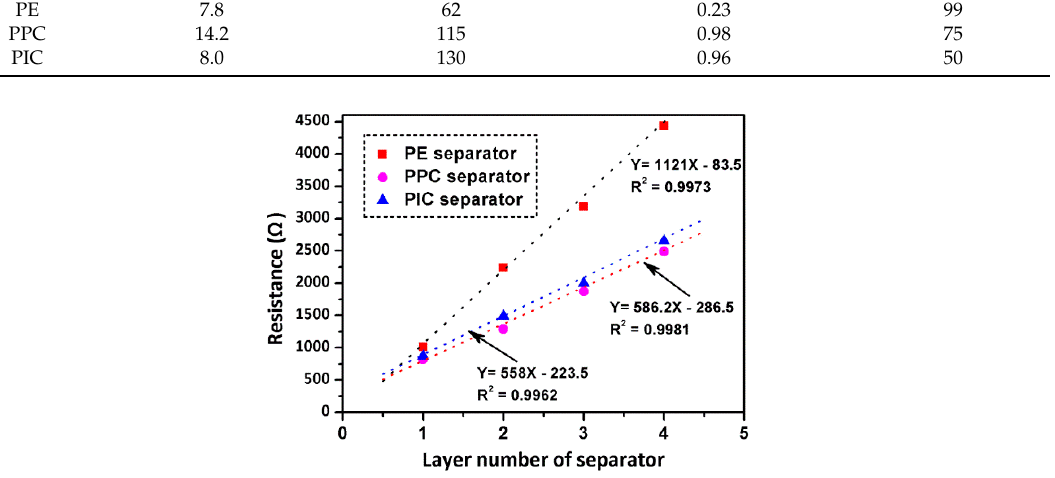
Table 2. Basic physical and electrical parameters of separators.